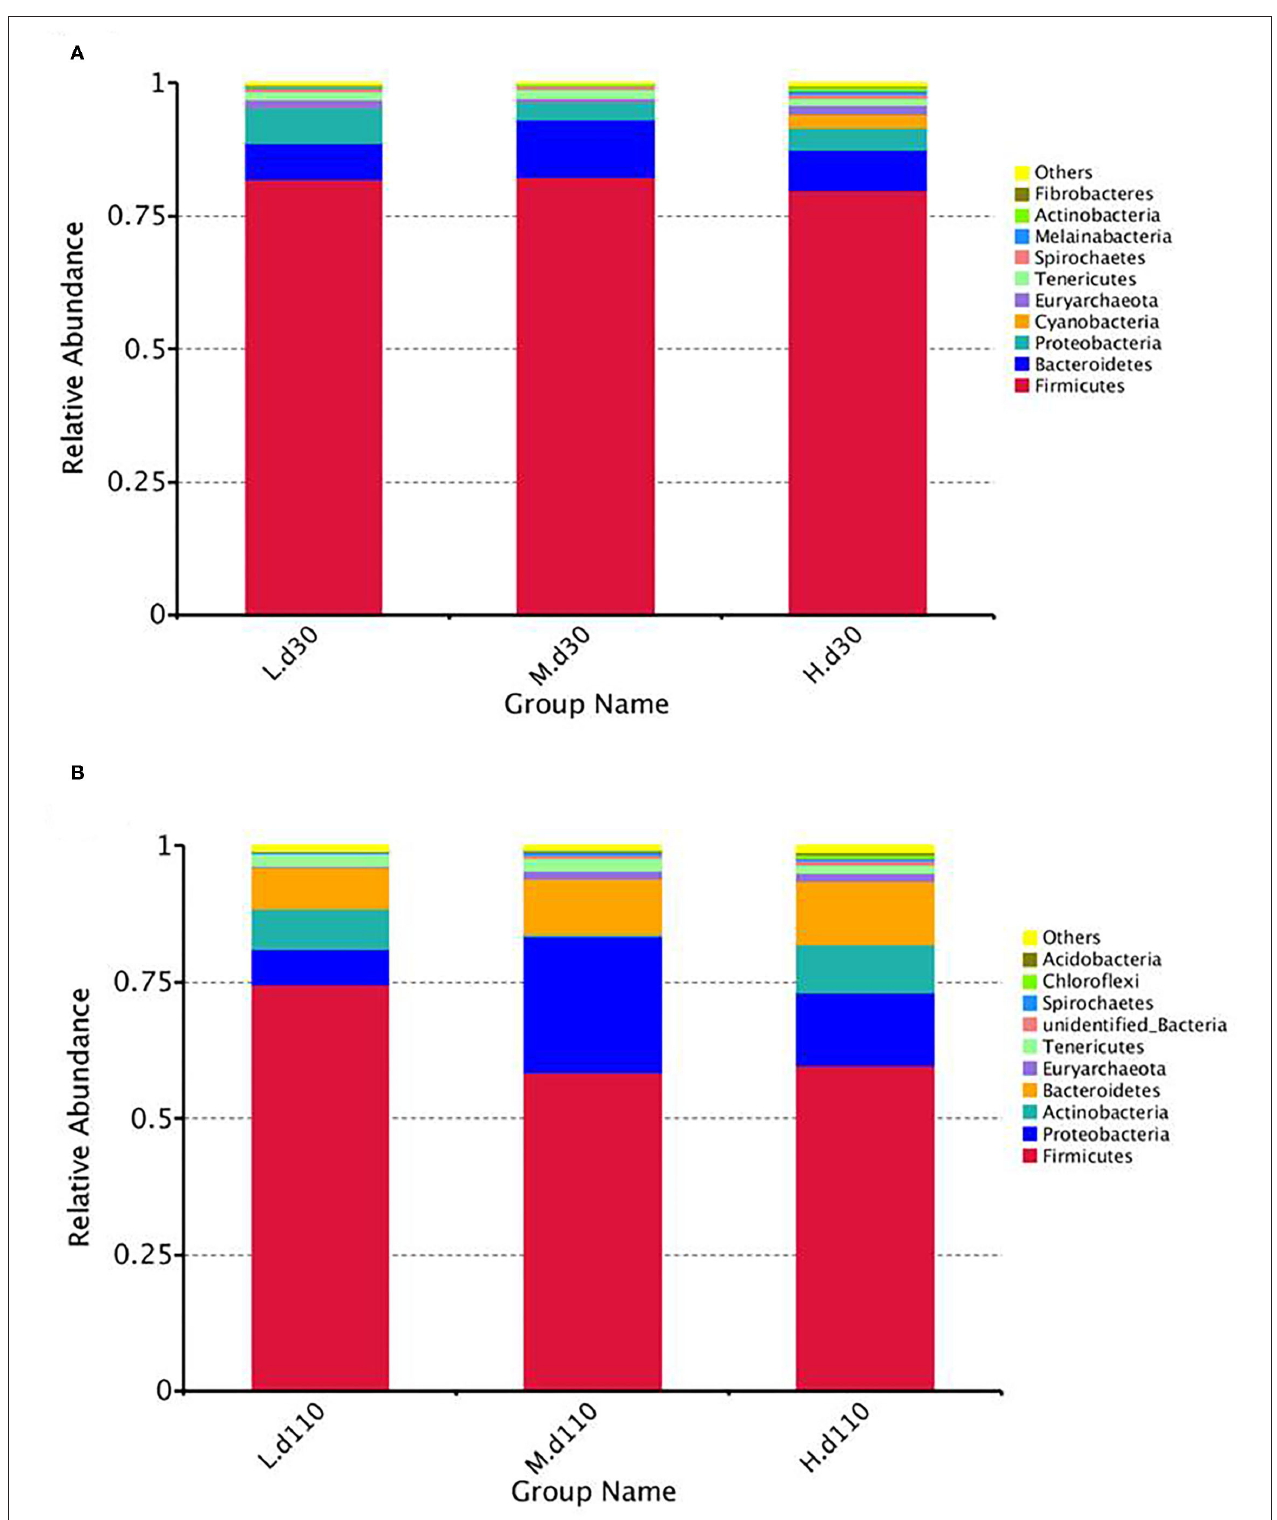
FIGURE 8 | Relative abundance of intestinal microbiota at the phylum levels at day 30 of gestation (A) and day 110 of gestation (B) . L, 1,050 mg/kg choline group; M, 1,850 mg/kg choline group; H, 2,650 mg/kg choline group. N = 8 for each treatment.